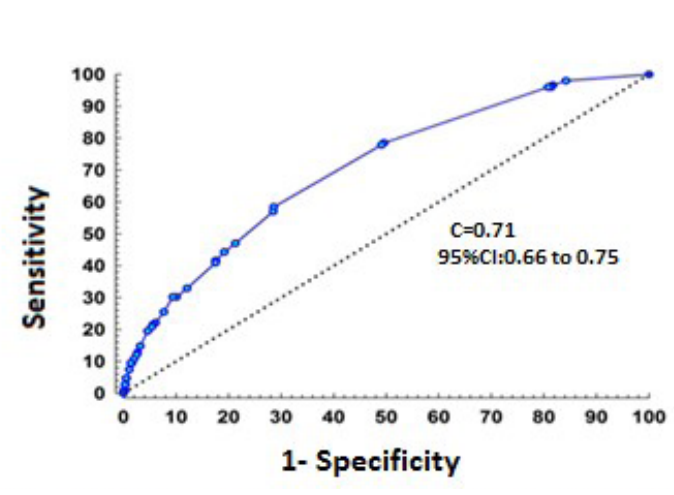
Fig. 1 – Area under the receiver operating characteristic (ROC) curve for detection of the outcome stroke. C=area under the ROC curve; 95% confidence interval (CI)=0.71 (0.66 – 0.75) for the final risk model (n=4,862).